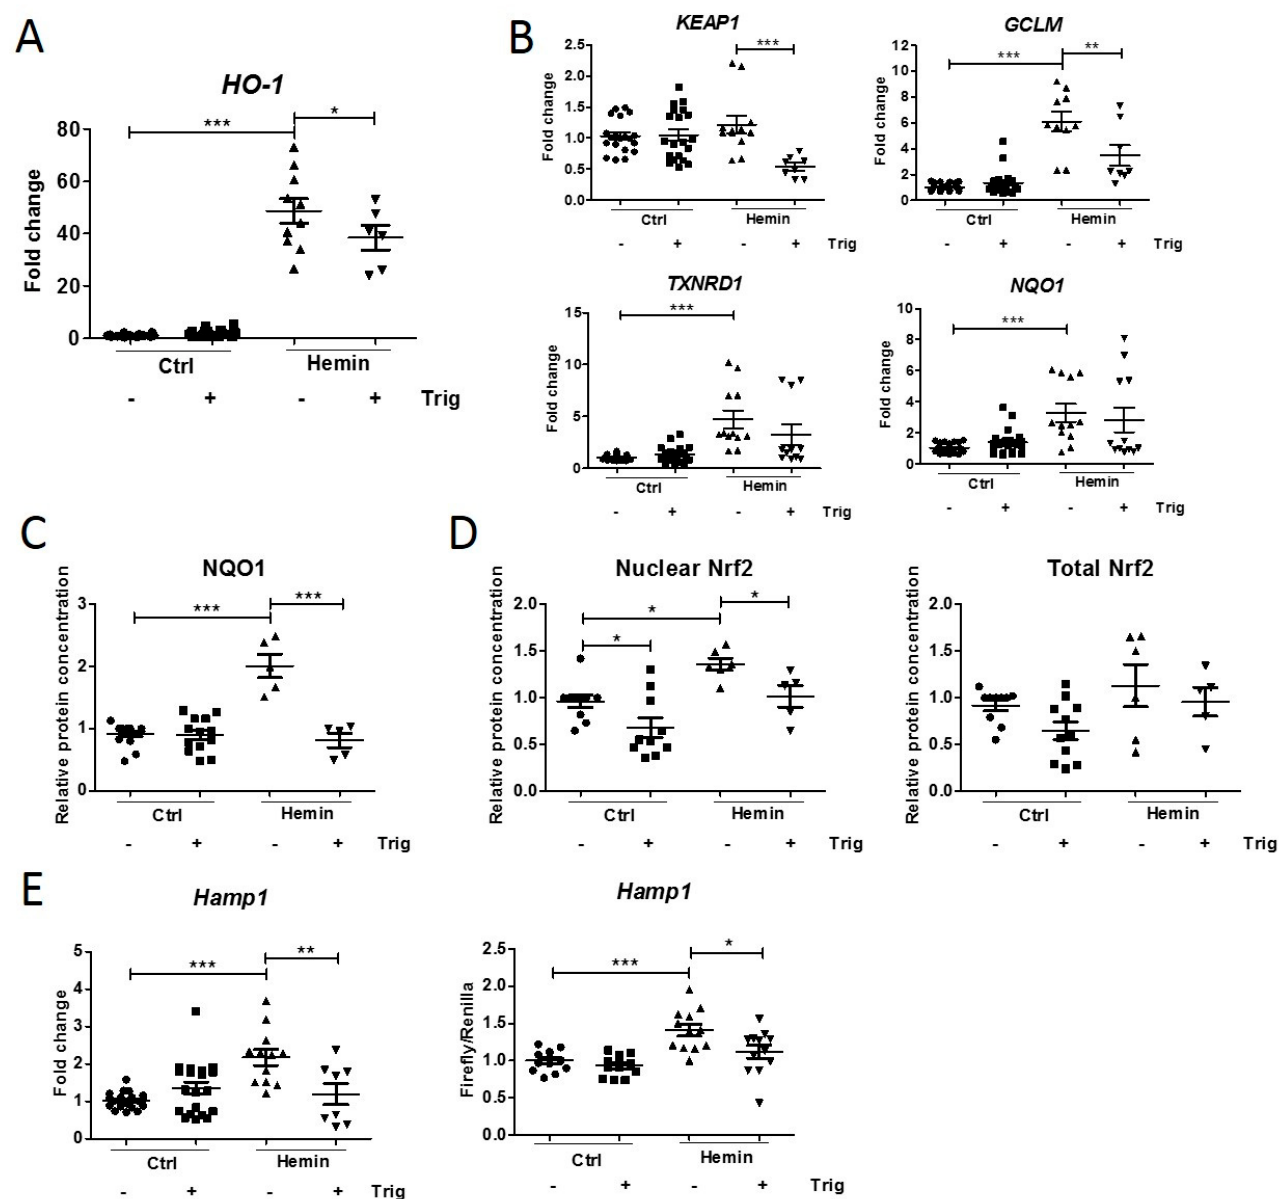
Figure 2. Hemin-induced Nrf2 pathway activation and subsequent downregulation using trigonelline in mCCD cl1 cells. ( A ) HO-1 , ( B ) KEAP1 , GCLM , TXNRD1 , NQO1 mRNA expression, and ( C ) nuclear Nrf2, total cellular Nrf2, and ( D ) NQO1 protein concentrations after 4 h of 10 µM hemin incubation with or without 1 µM trigonelline (trig). ( E ) Hamp1 mRNA expression and hepcidin synthesis in mCCD cl1 cells after 10 µM hemin with or without 1 µM trigonelline for 4 h. PBS was used as a control. Protein concentrations were relative to either histone H3 (nuclear fraction) or β -actin (total cell lysate). Representative images and graphs (mean ± SEM) show the mean of three independent experiments. Circles, squares and triangles show individual data points in the indicated treatment group. * p < 0.05, ** p < 0.01, *** p < 0.001 compared to the control using a one-way ANOVA with Bonferroni’s multiple comparisons test or a t-test.